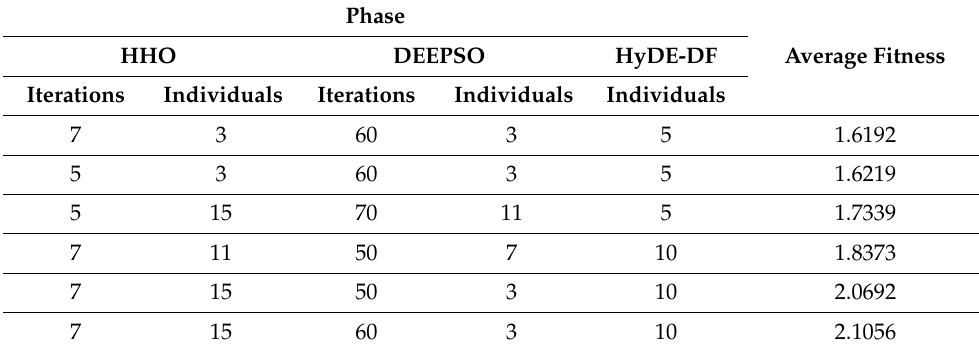
Table 5. Some tuning combinations (HyDE-DF iterations necessary to complete 10,000 fitness function